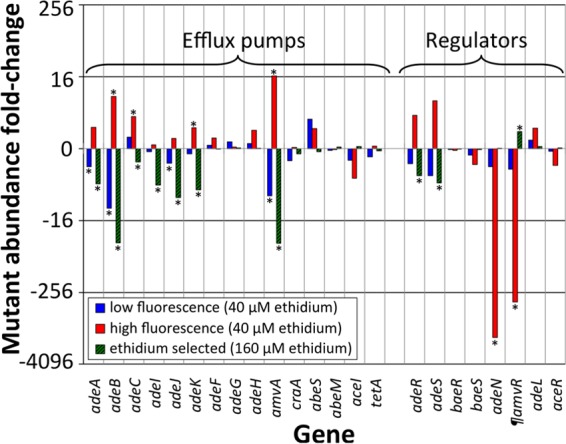
Selection of A. baumannii mutants carrying insertions in genes encoding the characterized efflux pumps AdeABC (12), AdeIJK (10), AdeFGH (20), AmvA (13, 14), CraA (21), AbeS (22), AbeM (23), and AceI (24, 25) and regulators AdeRS and BaeRS, which control expression of adeABC (15, 26); AdeN, which controls adeIJK (16); AdeL, which controls adeFGH (20); and AceR, which controls aceI (27). Bars represent the fold change in mutant abundance in cells selected for low ethidium fluorescence (blue), high ethidium fluorescence (red), or growth in 62.5 µg/ml (approximately 158 µM) ethidium bromide (hatched green; 1/4× MIC) compared to the starting mutant pool. Positive values indicate higher mutant abundance in the selected pool, whereas negative values indicate lower abundance. Asterisks indicate values supported by a Q value of 0.05 or below. ¶, the gene named here as amvR encodes a TetR family regulator that represses amvA gene expression (see text for details).